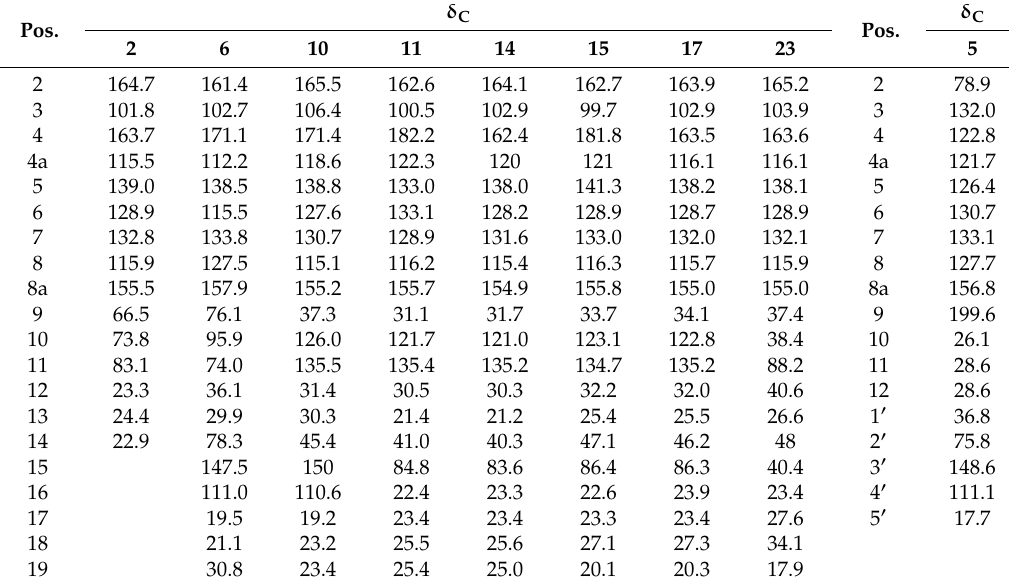
Table 2. 13 C NMR (150 MHz) Spectroscopic Data of 2 , 5 , 6 , 10 , 11 , 14 , 15 , 17 , and 23 a .